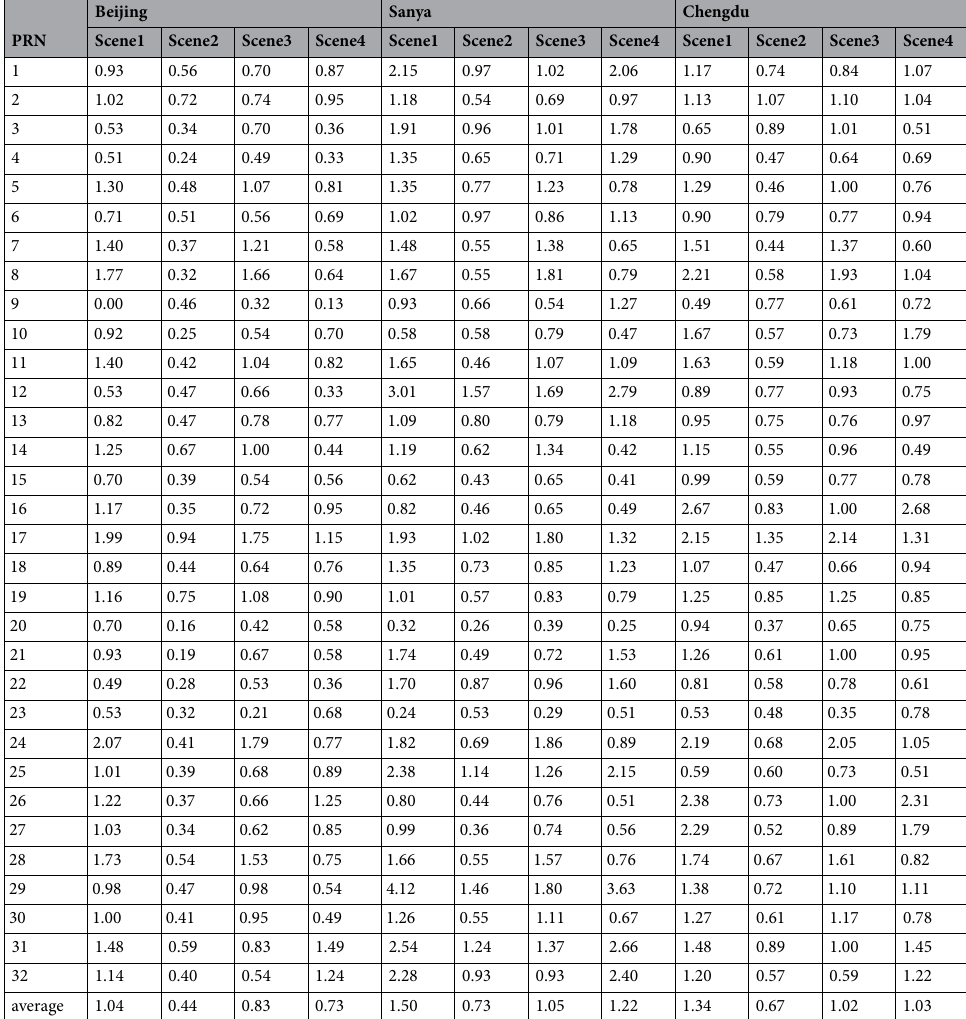
Table 4. Evaluation of the UERE under different scenes (Beijing, Sanya and Chengdu, unit: